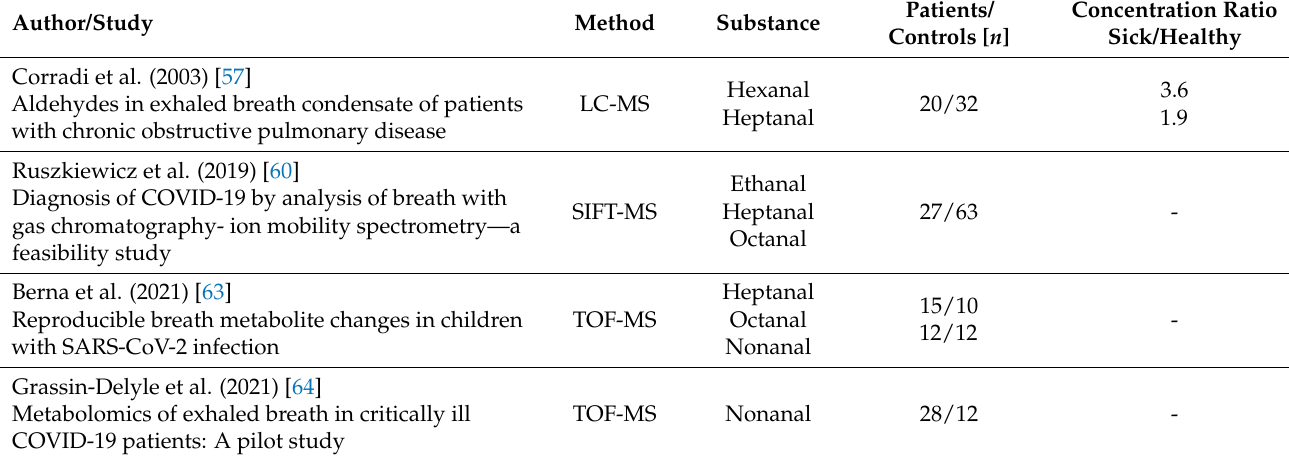
Table 3. Aldehydes as biomarkers of inflammatory/infectious lung diseases and mechanical lung